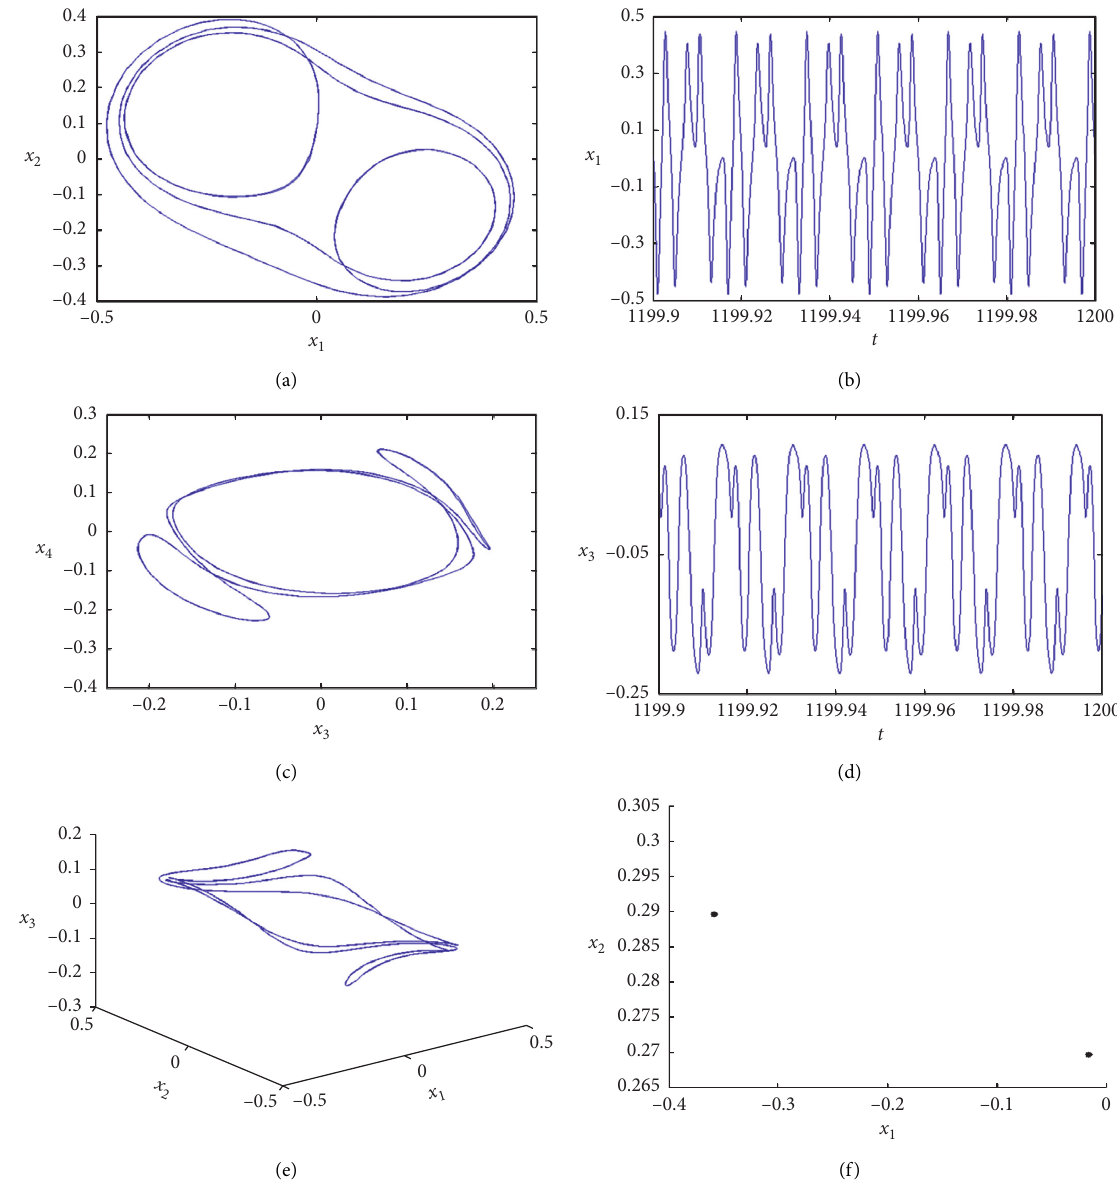
Figure 10: The period-2 oscillation of the cantilevered pipe conveying pulsating fluid is obtained when the parametric excitation of the flow � 19 . 5. (a) phase portrait on plane ( x velocity is U 0 ) , (e) three-dimensional phase portrait in space ( x on plane ( t, x 3